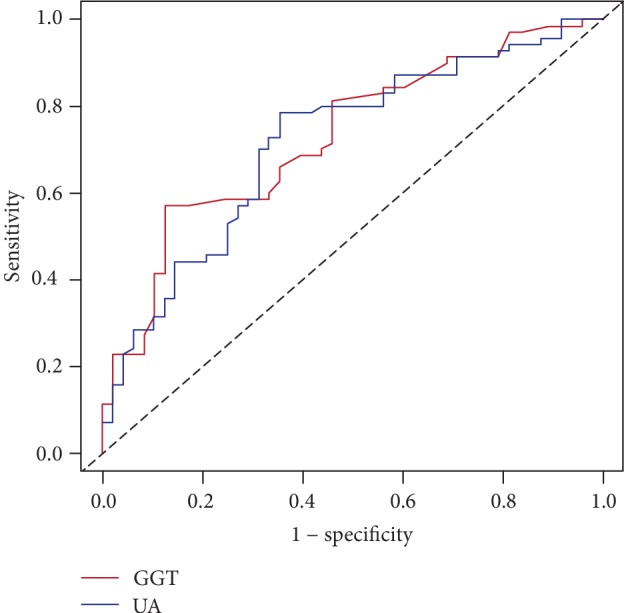
Time-dependent ROC curves for survival prediction. Note: the time-dependent receiver operating characteristic (ROC) curves were plotted to determine the optimal cut-off value.